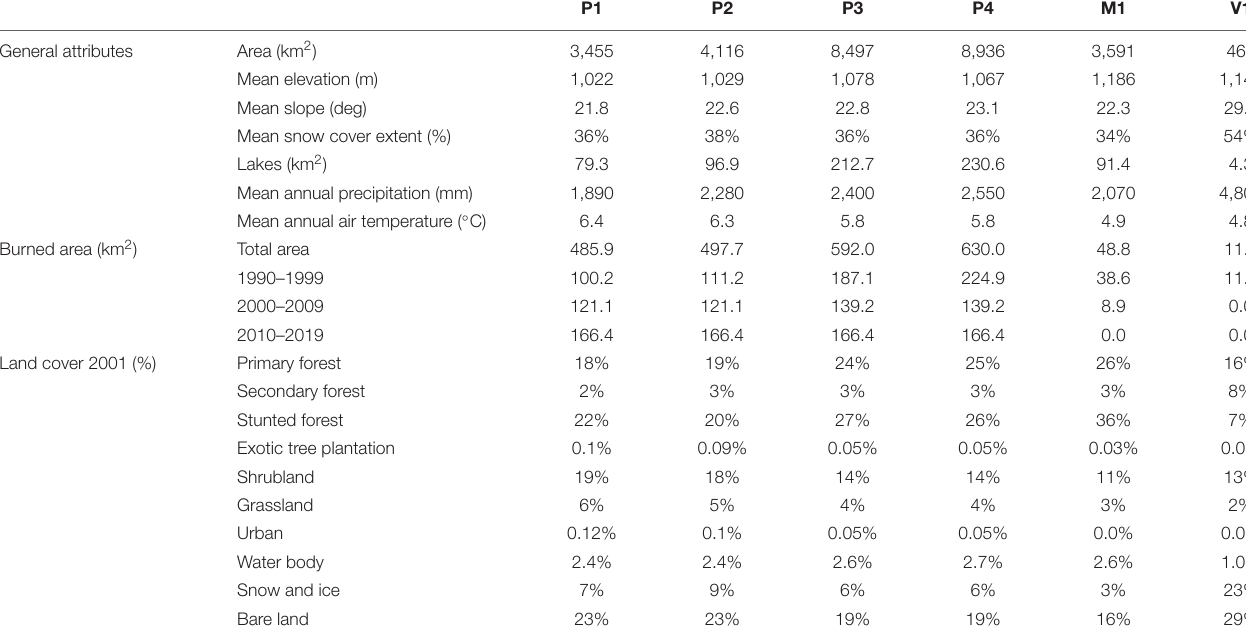
TABLE 1 | Biophysical attributes of each sub-basin delimited by the sampling points within the Puelo River Basin ( Figure 1 ). P1 P2 P3 P4 M1